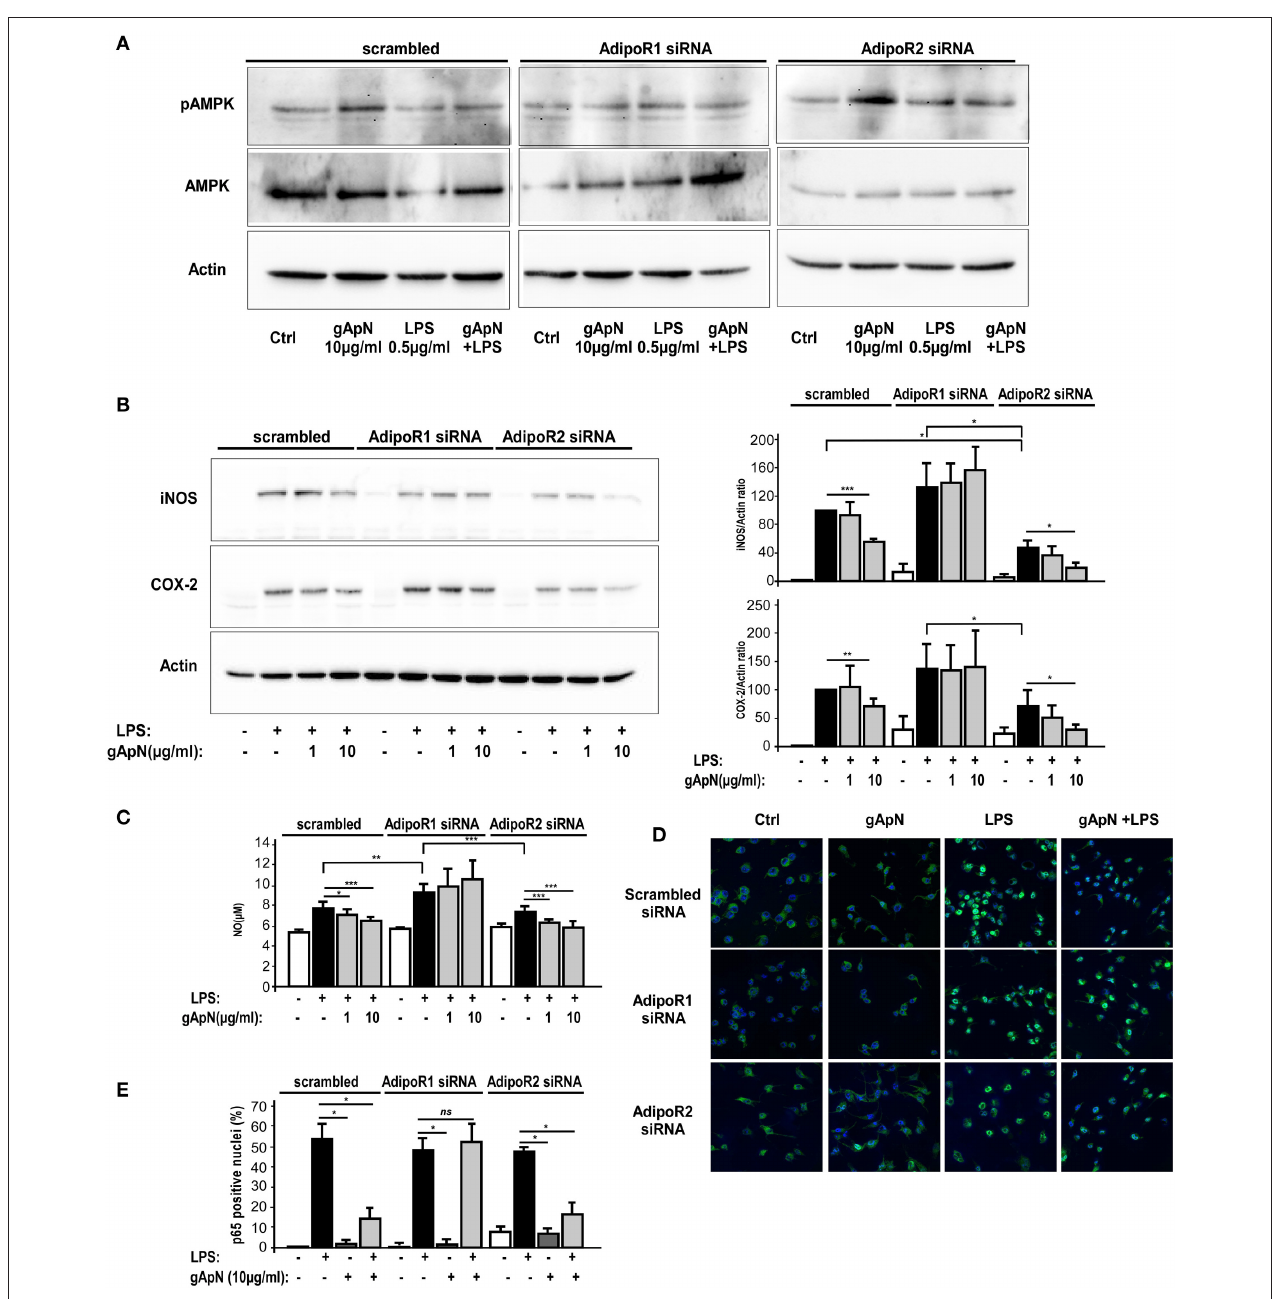
FIGURE 8 | AMPK phosphorylation, anti-oxidative and anti-nitrosative properties of globular adiponectin on microglia depend on AdipoR1 expression. BV2 cells were transfected with scrambled, AdipoR1 or AdipoR2 specific siRNAs as described in the Materials and Methods section. Forty-eight hours after transfection, cells were pre-treated with saline or gApN 1h before addition of LPS for 15h. (A,B) Representative western-blot analysis of LPS, gApN, and gApN LPS treatment on AMPK + phosphorylation on Thr172 (A) , iNOS ( B , upper panel) and COX-2 ( B , lower panel) immunoreactivities in BV2 cells transfected with scrambled (left panels), AdipoR1 (middle panels), or AdipoR2 (right panels) specific siRNAs. Actin immunoreactivity is used as a loading control. (B) Histograms show western-blot quantification of iNOS (upper histograms) and COX-2 (lower histograms) immunoreactivities in siRNA transfected BV2 cells pre-treated with saline (white and black bars) or gApN (gray bars) before addition of saline (white bars) or LPS (black and gray bars). (C) Nitric oxide (NO) release was quantified in medium of siRNA transfected BV2 cells pre-treated with saline (white and black bars) or gApN (gray bars) before addition of saline (white bars) or LPS (black and gray bars). N 4 per group; Kruskal–Wallis = test followed by the Iman-Conover method for multiple comparison between groups was performed, * p < 0.05, ** p < 0.01, *** p < 0.005. (D) Representative photomicrographs of p65 NF- κ B subunit immunoreactivity (green fluorescence) in BV2 transfected with scrambled (upper panels), AdipoR1 (middle panels), or AdipoR2 (lower panels) siRNAs pre-treated with saline or gApN before addition of LPS. Nuclei are stained with Hoechst blue fluorescent dye. (E) Quantification of p65 positive nuclei expressed as percentage of total nuclei in siRNA transfected BV2 cells pre-treated with saline (white and black bars) or gApN (gray bars) before addition of saline (white bars) or LPS (black and gray bars). N 4, Mann & Whitney for comparison between groups, * p < 0.05, ns, non-significant. =